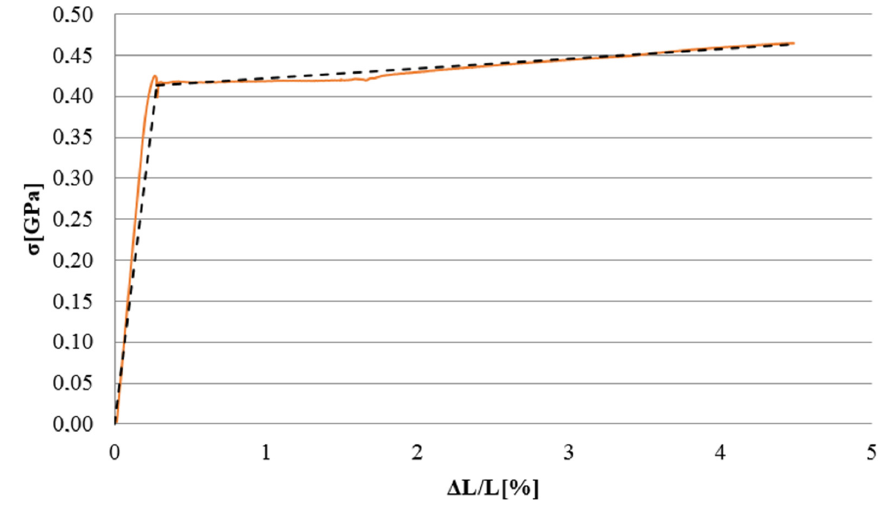
Figure 11. Material characteristics of the specimen made of steel: laboratory coupon test and numerical model.